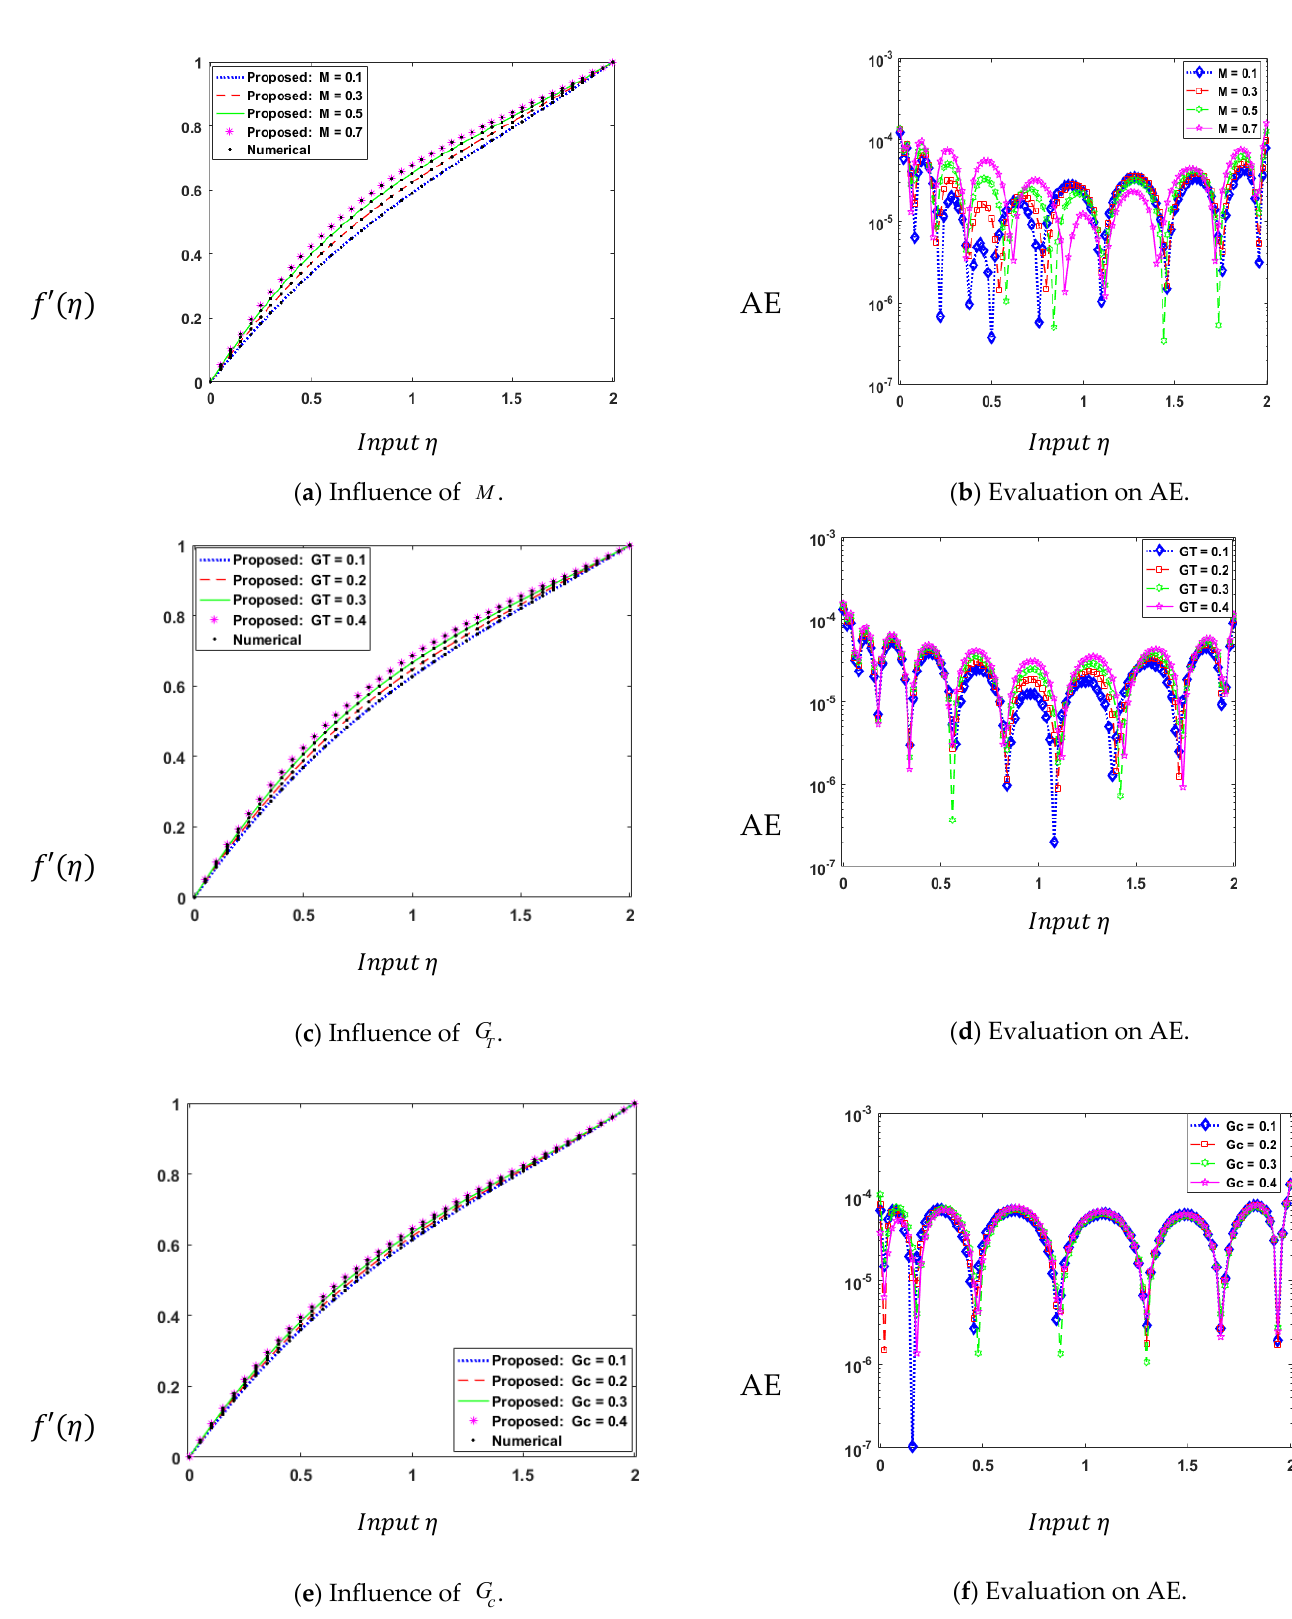
Figure 14. Evaluation of suggested TLMB-NN with outcomes of reference dataset for Scenarios 1–3 of HTM-BFN model with MHD.